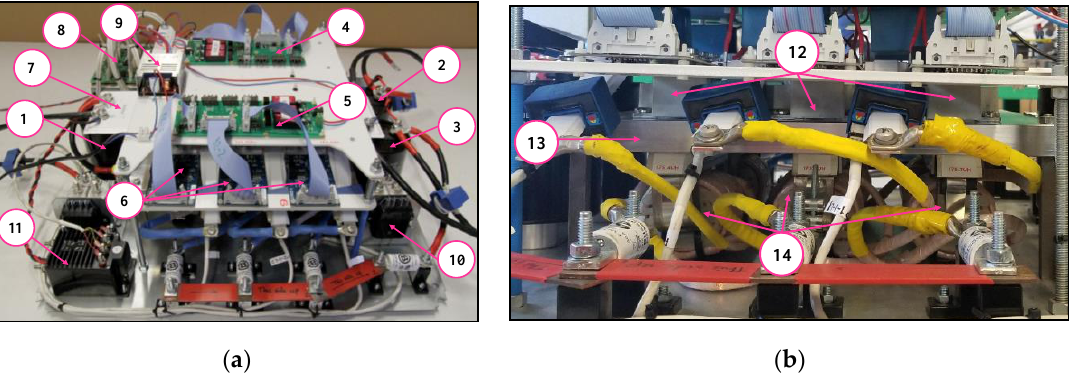
Table 7. compares the system specifications between the proposed prototype and different